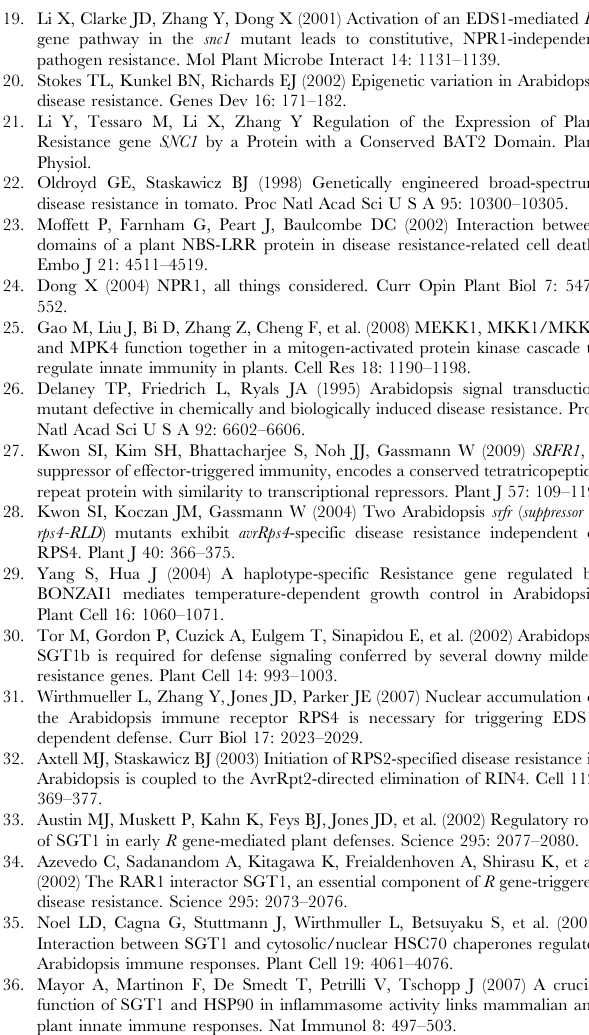
Figure S6 Yeast two-hybrid analysis of self-association of the TPR domain of SRFR1. Figure S7 Western blot analysis of the SRFR1 protein in wild type and snc5 mutants using the anti-SRFR1 antibody. Figure S8 Localization of SRFR1 and MPK4. Immunoblot analysis of SRFR1 and MPK4 in nuclei-depleted ( D N) and nuclear (N) protein extracts of wild type plants. Equal proportions of nuclei-depleted and nuclear protein extracts were loaded. Anti- PEPC was used as a cytosolic marker, and anti-Histone H3 was used as a nuclear marker.